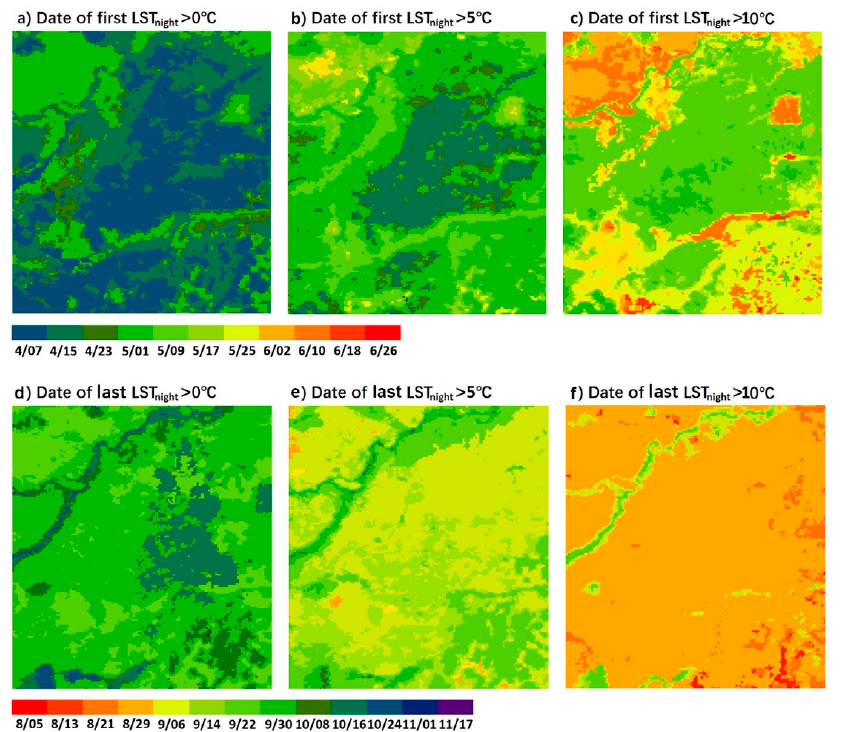
Figure 4. The Spatial-temporal changes of nighttime LST derived from MYD11A2 data in 2018. ( a ) The first date with nighttime LST ≥ 0 ℃ ; ( b ) the first date with nighttime LST ≥ 5 ℃ ; ( c ) the first date with nighttime LST ≥ 10 ℃ ; ( d ) the end date with nighttime LST ≥ 0 ℃ ; ( e ) the end date with nighttime LST ≥ 5 ℃ ; ( f ) the end date with nighttime LST ≥ 10 ℃ .